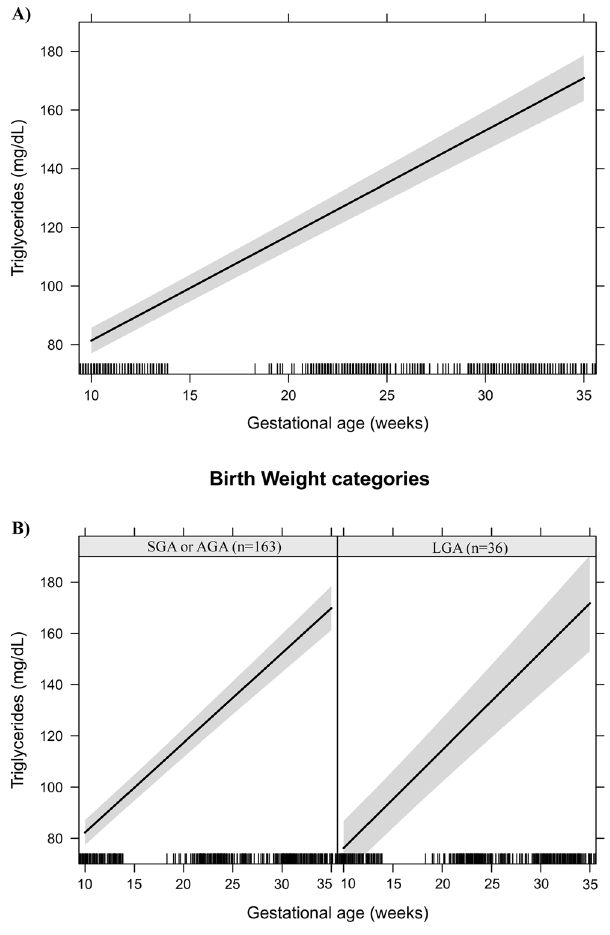
Figure 4. Triglycerides changes during pregnancy in a sample of 199 women and their newborns followed at a public health centre in Rio de Janeiro city, Brazil, 2009–2012. ( A ) Change per gestational week. ( B ) Change per gestational week according to birth weight categories. Note: The models were adjusted for age, education, smoking habit, pre-pregnancy leisure time physical activity, pre-pregnancy energy intake, glycaemia, parity, early pregnancy BMI, gestational weight gain and quadratic gestational age. Data are presented as linear mixed effect coefficient ( β ) and 95% CI. p-value refers to the maximum likelihood estimator. ( A ) Linear gestational age: β = 3.52 (3.26; 3.78), p < 0.001. ( B) SGA or AGA - Linear gestational age: β = 3.45 (3.16; 3.74), p < 0.001. LGA - Linear gestational age: β = 3.79 (3.23; 4.35), p <